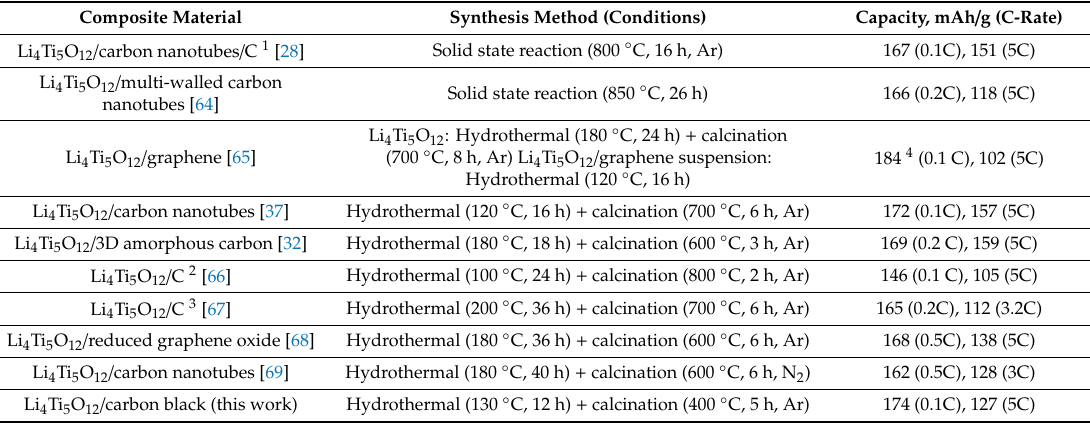
Table 3. Specific discharge capacities of the Li 4 Ti 5 O 12 / C composites with various carbon materials. Composite